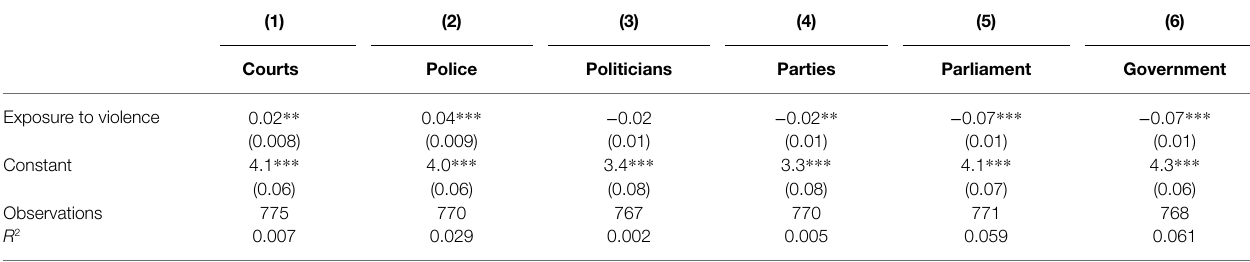
TABLE 4 | Exposure to violence and institutional trust in the settlement country.